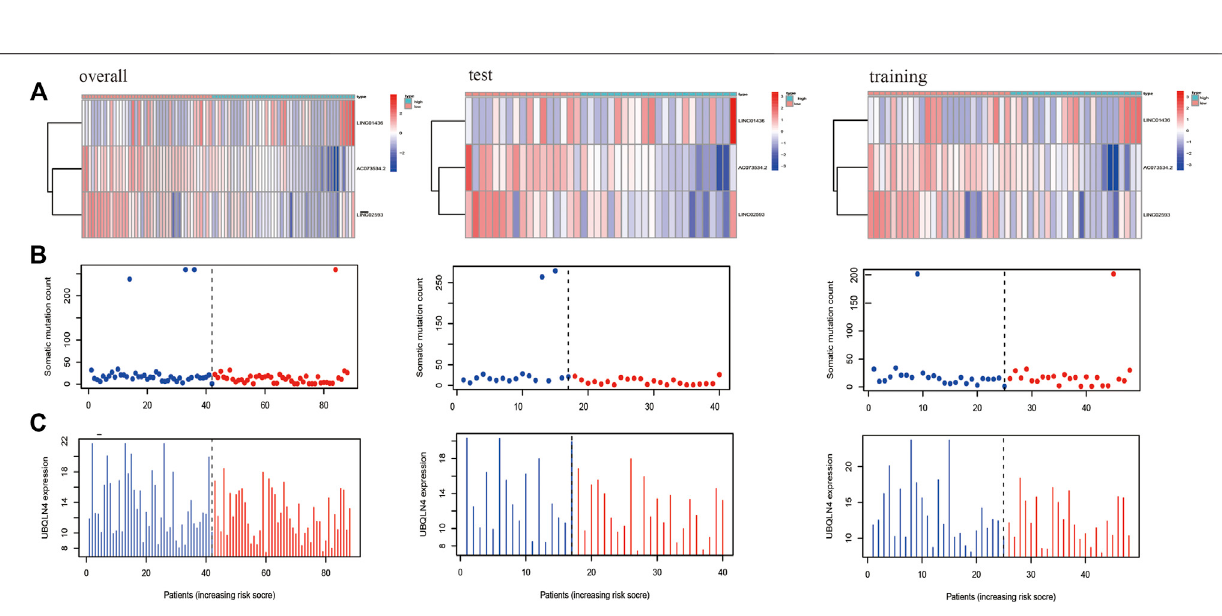
Frontiers in Bioengineering and Biotechnology |